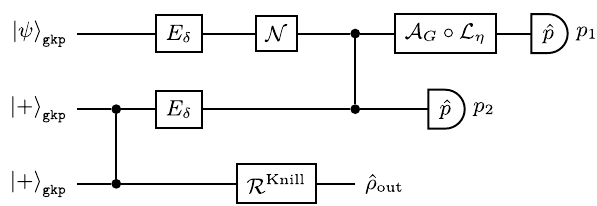
FIG. 9. Teleportation-based error-correction circuit for GKP codes with the type and location of noise terms we are consid- ering. We assume that the ancilla states are regularized through E δ only after they are entangled through the CZ operation such that this circuit implements a logical channel of the form Eq. (10). The regularized input state is then subject to a simultane- ous loss and dephasing channel N that is obtained from master equation (16). The measurement model assumes standard